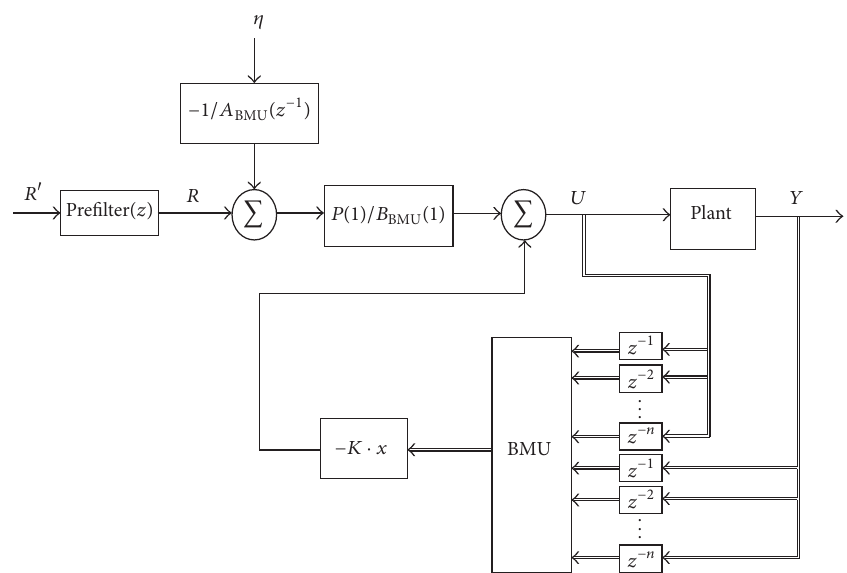
Figure 1: Control strategy by state feedback and local linear models.